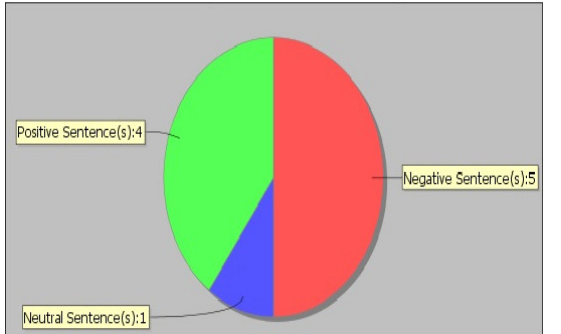
FIG. 2: OUTPUT OF THE URDU SENTIMENT ANALYZER